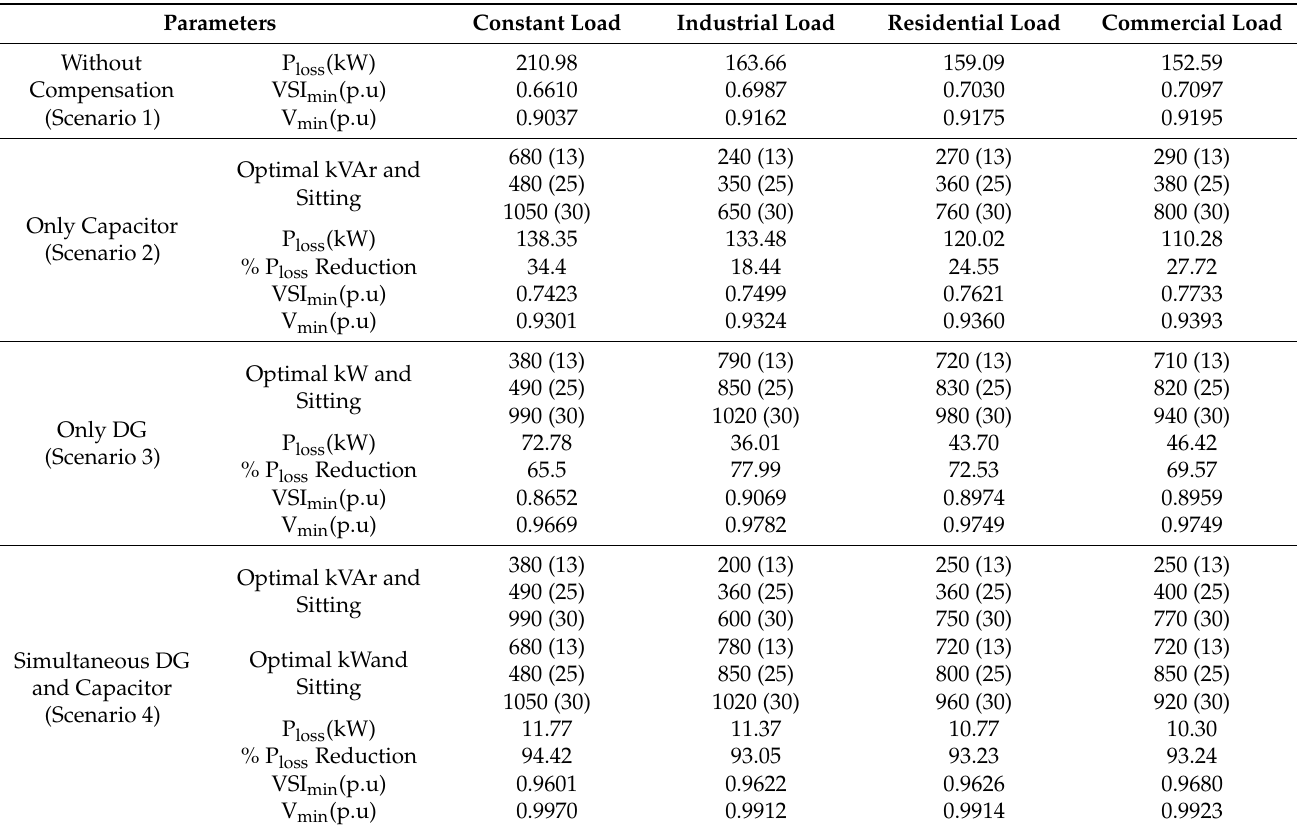
Table 3. Results of IEEE 33 RDS (various load